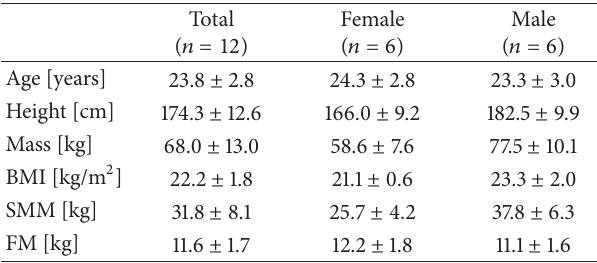
Table 1: Participants’